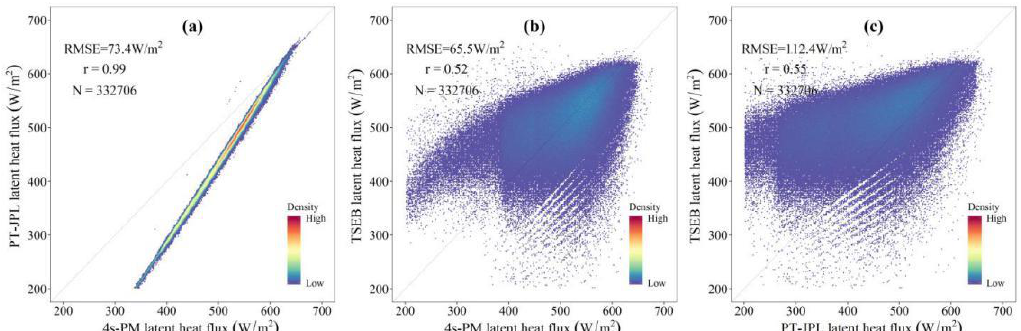
Figure 10. Density plots of comparisons of maize instantaneous latent heat flux derived from Landsat 8 for the three models (( a ) 4s-PM vs PT-JPL, ( b ) 4s-PM vs TSEB, ( c ) PT-JPL vs TSEB) on 19 August of 2014. The legend refers to the frequency of data points at each location.